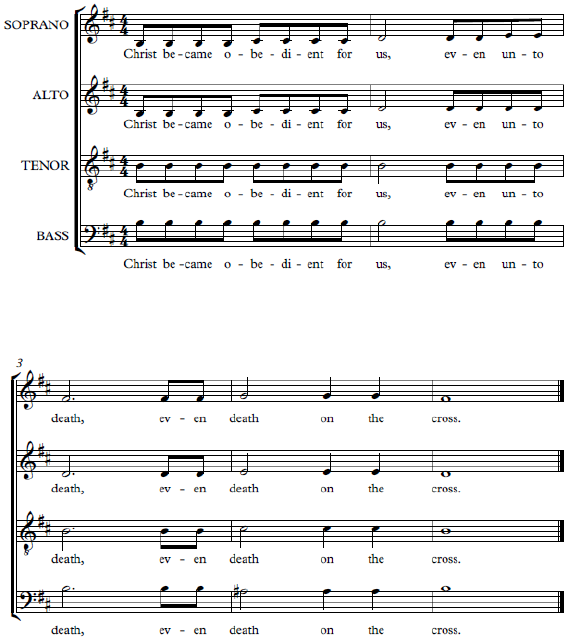
Figure 5. An excerpt from an unpublished work by R. Joseph